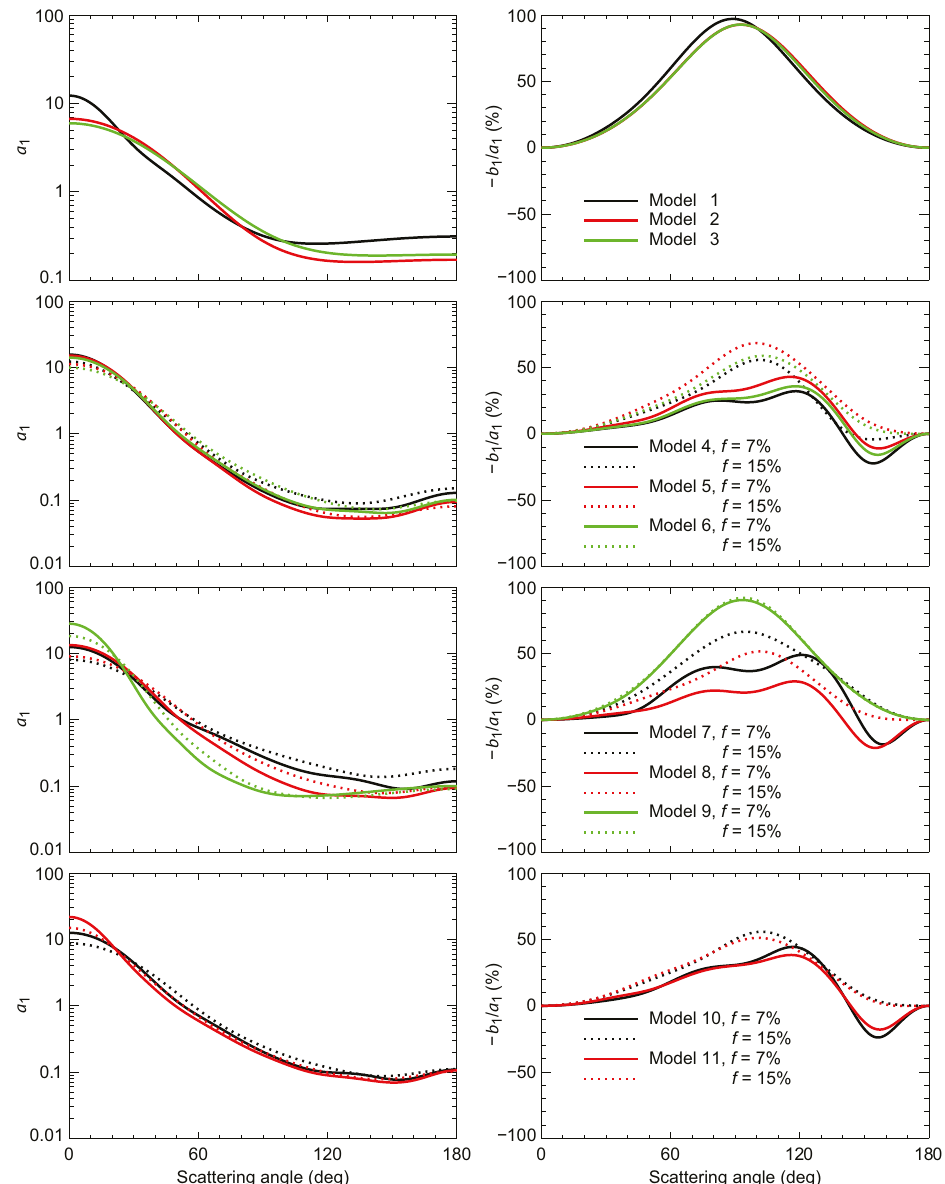
Figure 8. Phase function (left-hand panels) and linear polarization (right-hand panels) at λ = 532 nm for different polydisperse carbonaceous aerosols. The solid and dotted curves depict the results for soot volume fractions f = 7% and 15%, respectively.